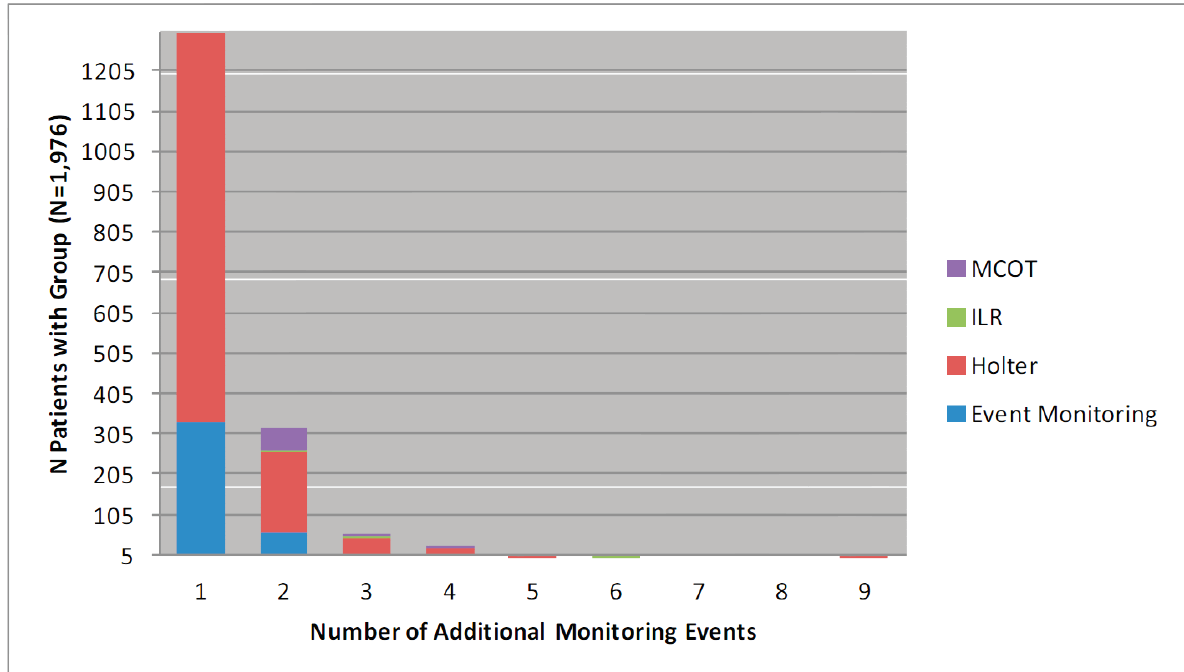
Figure 4. Time to First Repeat Monitor Event after Index Holter by Monitor Type-Group 2a